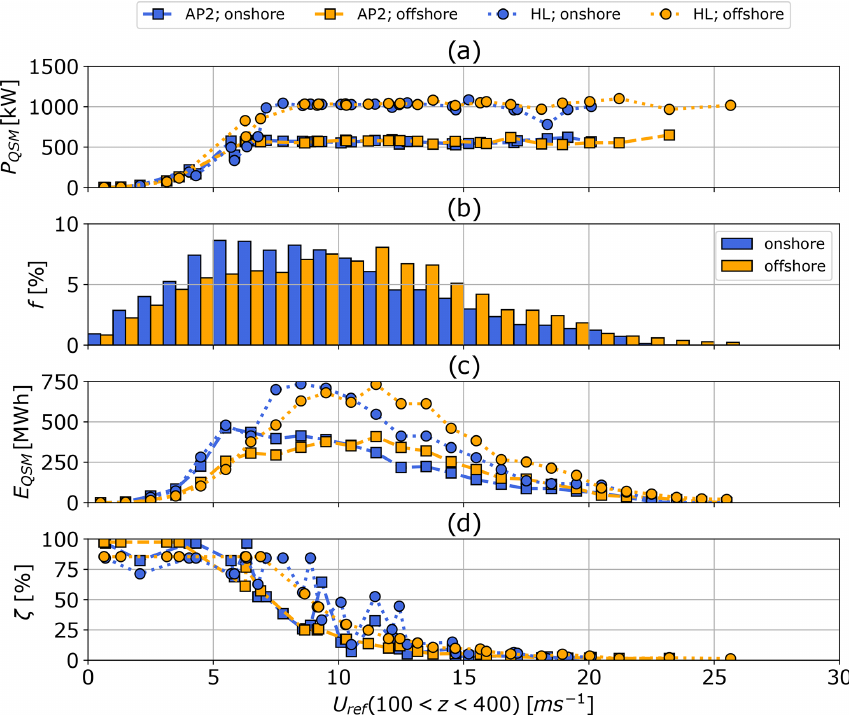
Figure 10. QSM-based power curves (a) for a wing area of A = 50m 2 , both sets of HL (circle) and AP2 (square) reference aerodynamic coefficients and both onshore (blue) and offshore (orange) locations. Optimal power P Loyd is derived from p5, p25, p50, p75, p95 wind speed profiles within each of the k = 10 WRF-simulated clusters. Diagram (b) presents the average annual wind speed probability distribution over a reference height range of 100 ≤ z ref ≤ 400m. The annual energy production distributions over the wind speed are depicted in (c) . Diagram (d) shows the corresponding harvesting factor ζ .